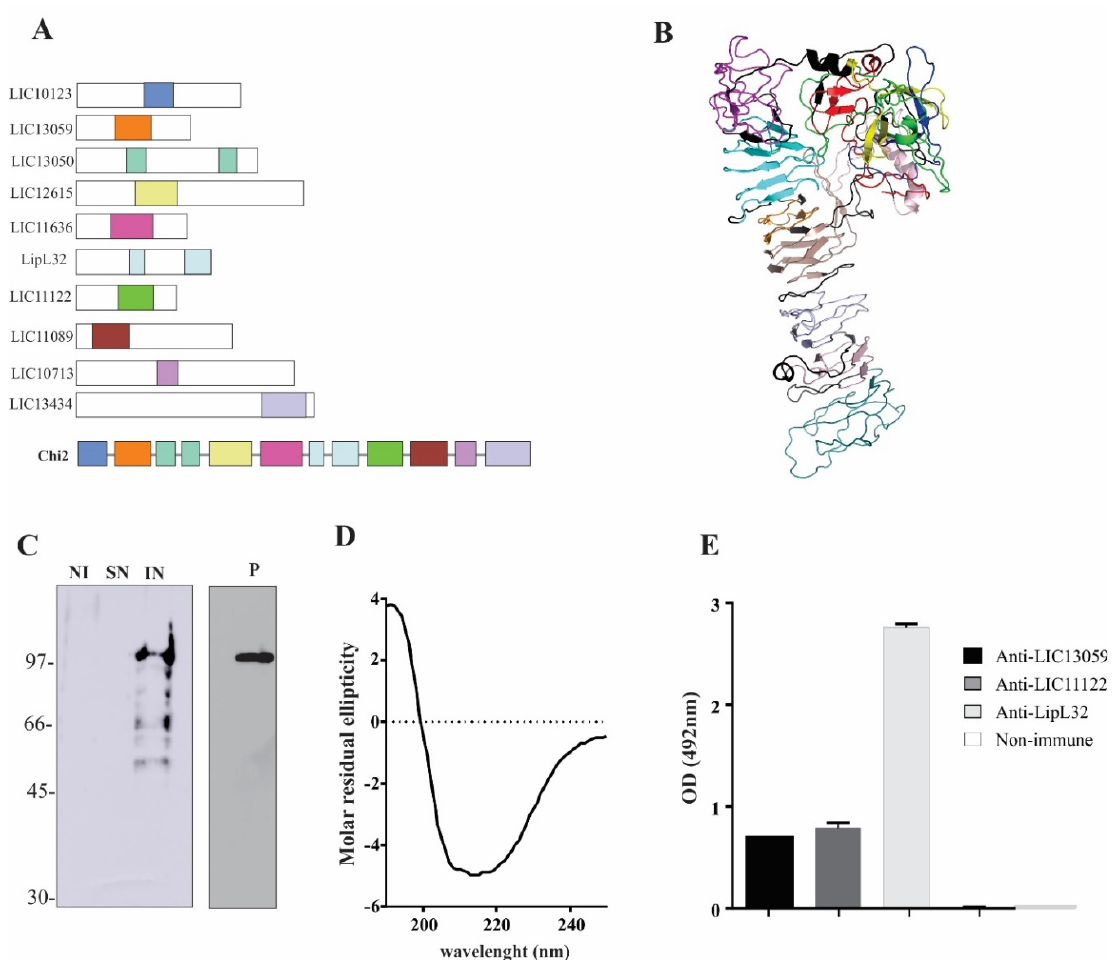
Figure 1. Chimeric protein design, expression, and characterization. Diverse regions of 10 conserved outer membrane proteins from L. interrogans were selected based on conserved domains and epitope prediction ( A ). The final amino acid sequence was used for protein modeling, indicating independent folding of each region that was interspaced by polypeptide linkers ( B ). Recombinant plasmid containing the chimeric protein coding sequence was used to transform E. coli BL21 (DE3) strain, and protein expression was induced by IPTG. After cell lysis, supernatant (SN) and pellet after 8M urea solubilization (IN) were evaluated via immunoblotting and probing with monoclonal anti-His antibodies ( C ). Recombinant protein was purified via metal-chelating chromatography from the insoluble fraction and reassessed via immunoblotting. Secondary structure content was evaluated via circular dichroism ( D ) and ELISA experiments with immobilized rChi2 demonstrated that the chimeric protein could be recognized by mouse hyperimmune serum against some of the proteins from which the portions were selected ( E ).